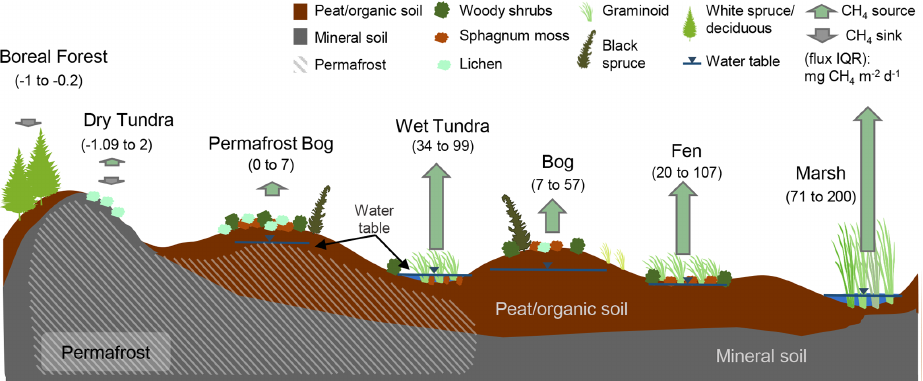
Figure 2. Conceptual diagram of the terrestrial land cover classes and their CH 4 -emitting characteristics including permafrost conditions, hydrology, organic layer depth, and associated nutrient and vegetation characteristics. Numbers within the brackets represent the interquartile (IQR) flux ranges. Arrows are scaled based on mean flux values. See Sect. 3.2 for a detailed breakdown of terrestrial